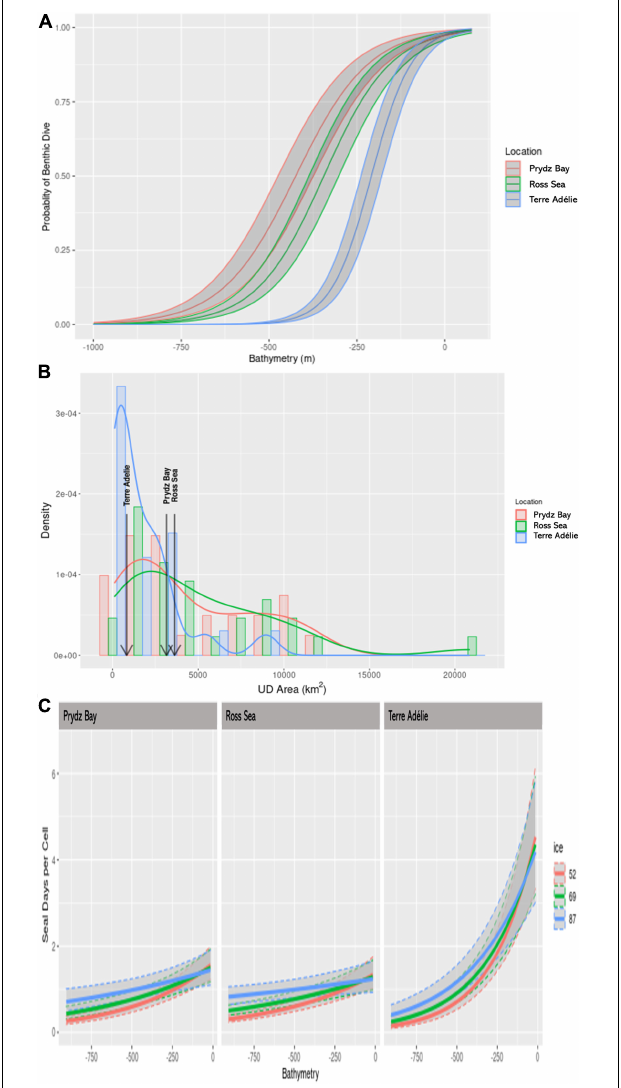
FIGURE 2 | (A) The predicted probability of a dive being benthic with respect to bathymetry, based on a binomial GLMM. Shaded areas represent 95% confidence intervals. (B) Frequency distribution (bars) and density (curves) of the area of individual Utilisation Distributions of Weddell seals from three regions in Antarctica. The arrows indicate the median areas for each of the locations. (C) Predicted values of seal days per cell from the best model using location, bathymetry and sea-ice concentration (day ∼ location + bathymetry, ice, bathymetry:location, bathymetry:ice). The figure illustrates the interaction between bathymetry and sea-ice concentration. In this case values were predicted for high (87%) medium (69%), and low (52%) ice concentrations (intervals set by the R package